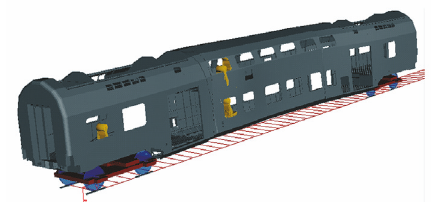
Figure 13: Modal shape of the 4th mode at 10.67 Hz.